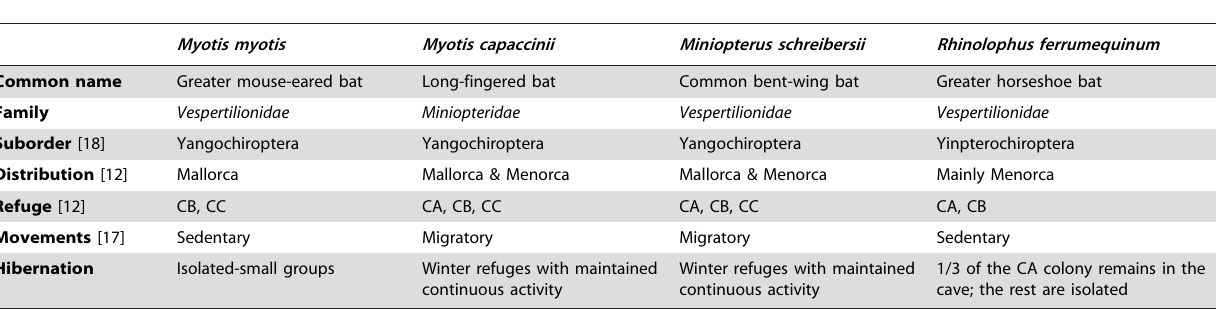
Table 1. Bat species